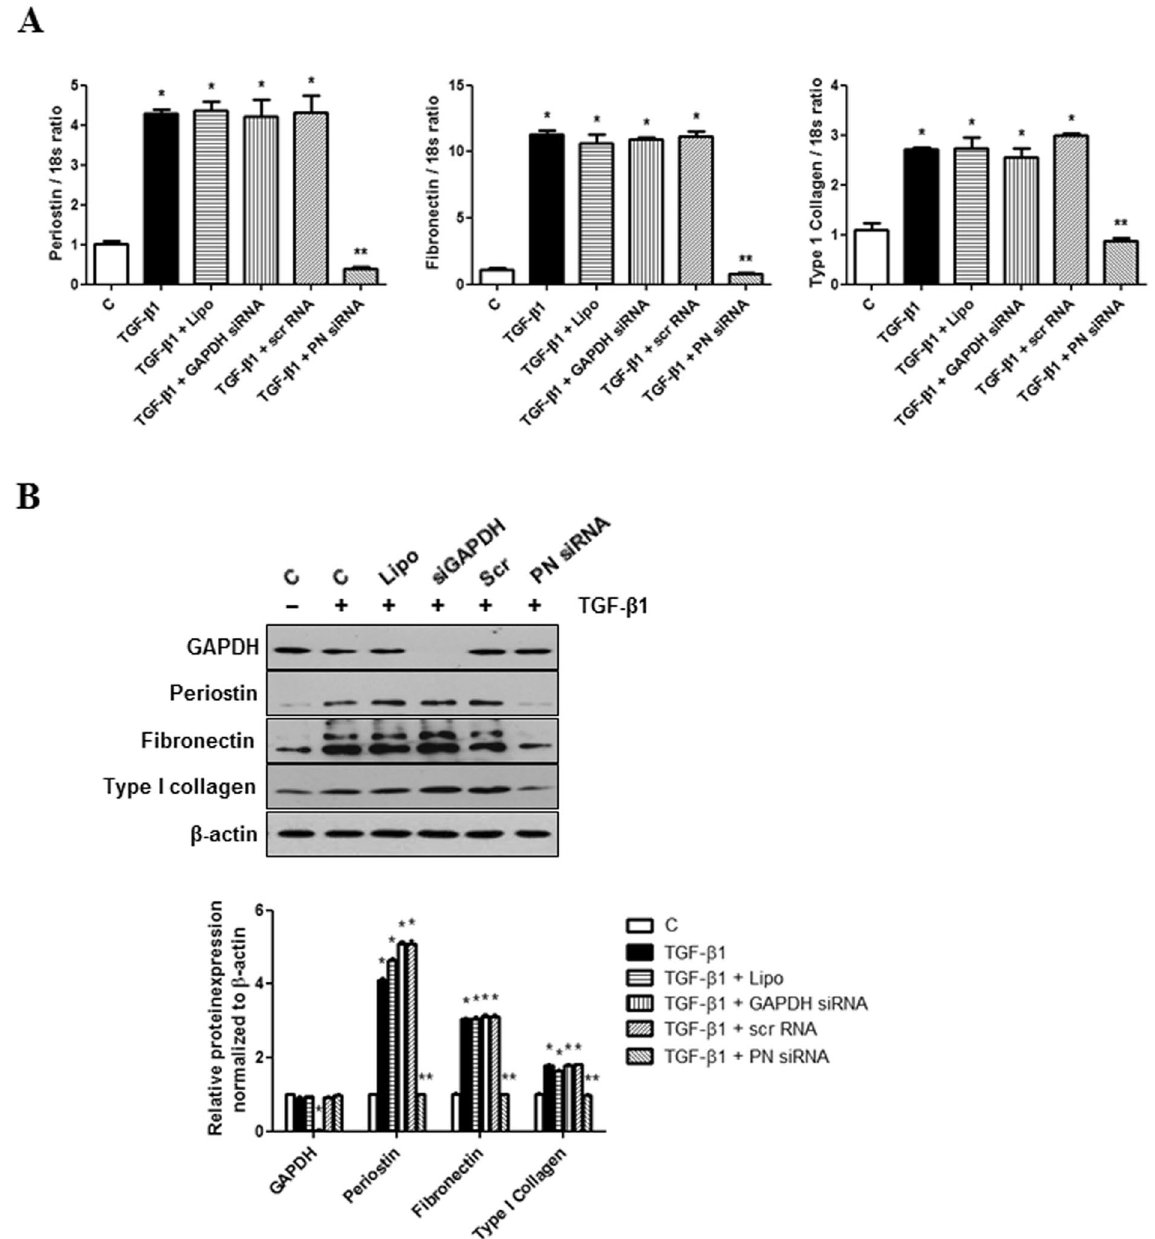
Figure 2. Changes in mRNA and protein expression of periostin, fibronectin, and type I collagen expression in inner medullary collecting duct (IMCD) cells following periostin siRNA transfection. ( A ) mRNA levels in TGF- β 1-stimulated (10 ng/ml) IMCD cells treated with or without periostin siRNA (100 nM) (n = 12). Periostin siRNA significantly attenuated TGF- β 1-induced increases in periostin, fibronectin, and type I collagen mRNA levels in IMCD cells treated with TGF- β 1. Positive control GAPDH siRNA transfection significantly down-regulated GAPDH mRNA level. Negative control scramble siRNA transfection did not affect the expression of mRNA levels. ( B ) A representative western blot analysis of protein expression in TGF- β 1-stimulated IMCD cells with or without periostin siRNA transfection (a representative of 4 blots). Periostin siRNA transfection significantly mitigated the increases in periostin, fibronectin, and type I collagen protein expression in TGF- β 1-stimulated IMCD cells. Positive control GAPDH siRNA transfection significantly down-regulated GAPDH protein level. Negative control scramble siRNA transfection did not affect the expression of protein levels. Uncropped scans are presented in Supplementary Figure 3. C, control; Lipo, lipofectamine; siGAPDH, GAPDH siRNA; Scr, negative control scramble siRNA; PN siRNA, periostin siRNA. * P < 0.05 vs. C; ** P < 0.05 vs. TGF- β